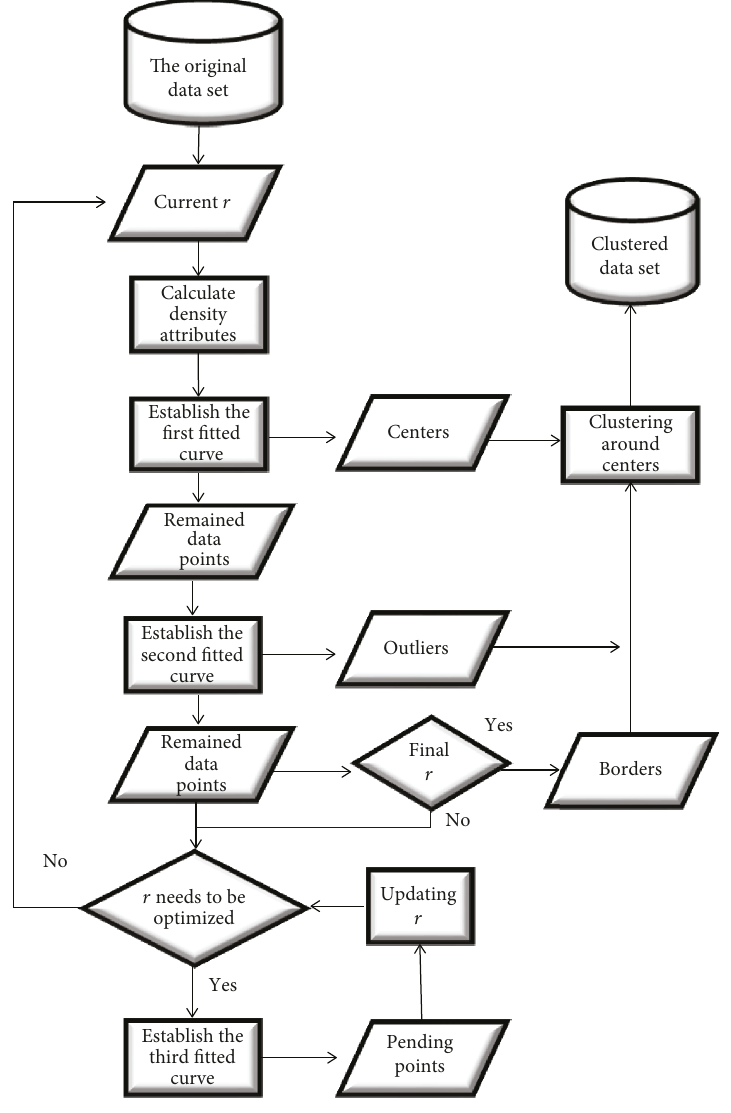
Figure 1: The fl ow of